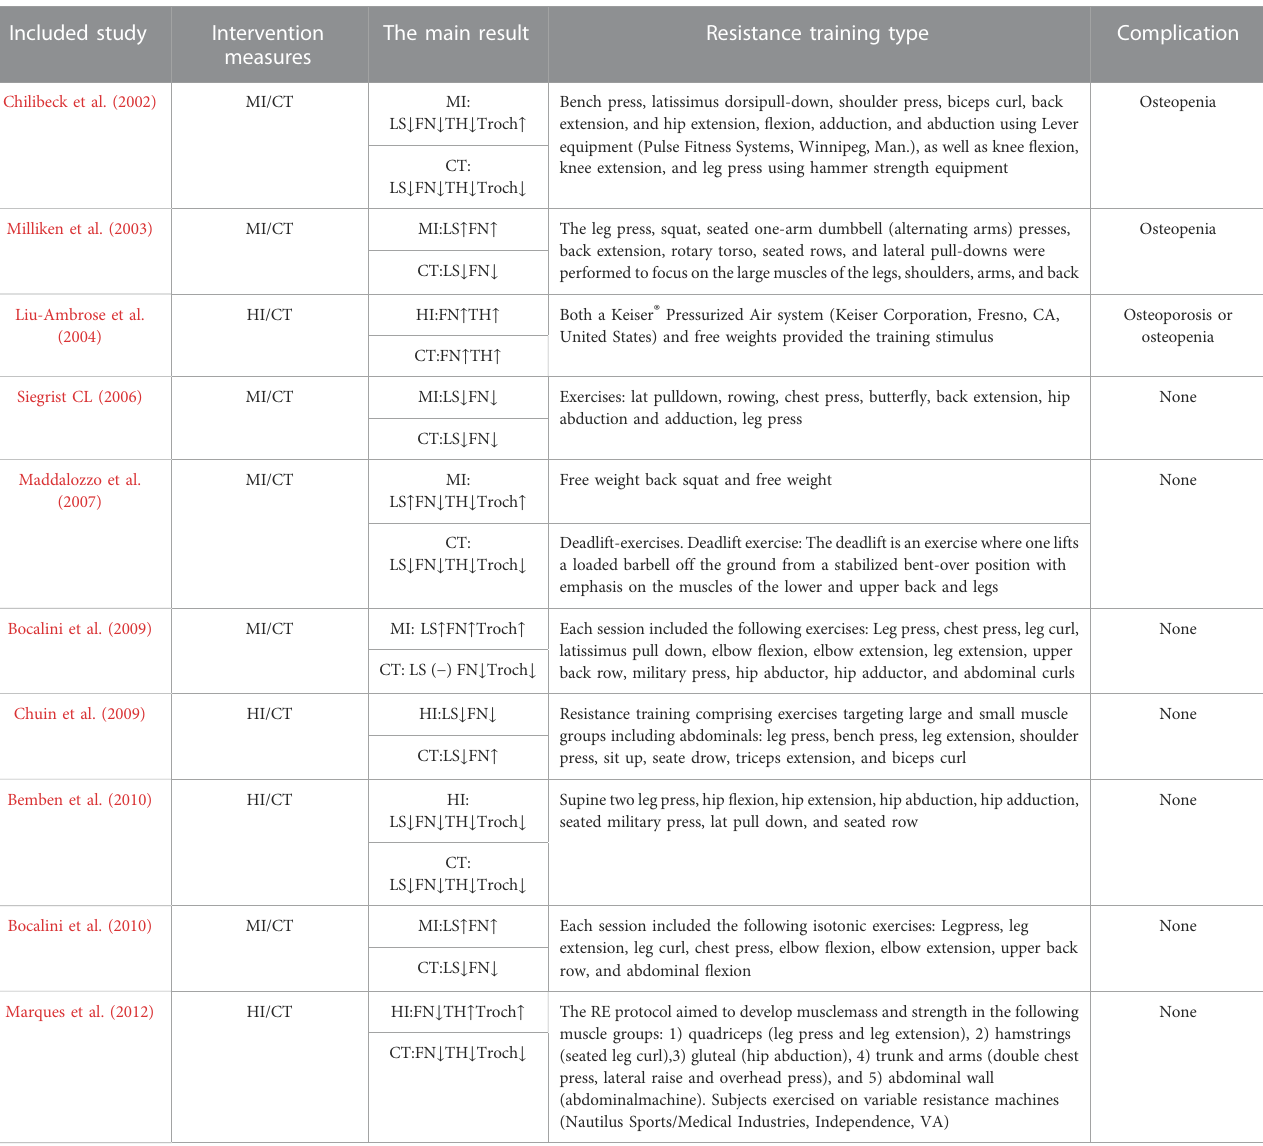
Each session included the following isotonic exercises: Legpress, leg extension, leg curl, chest press, elbow fl exion, elbow extension, upper back row, and abdominal fl exion The RE protocol aimed to develop musclemass and strength in the following muscle groups: 1) quadriceps (leg press and leg extension), 2) hamstrings (seated leg curl),3) gluteal (hip abduction), 4) trunk and arms (double chest press, lateral raise and overhead press), and 5) abdominal wall (abdominalmachine). Subjects exercised on variable resistance machines (Nautilus Sports/Medical Industries, Independence,